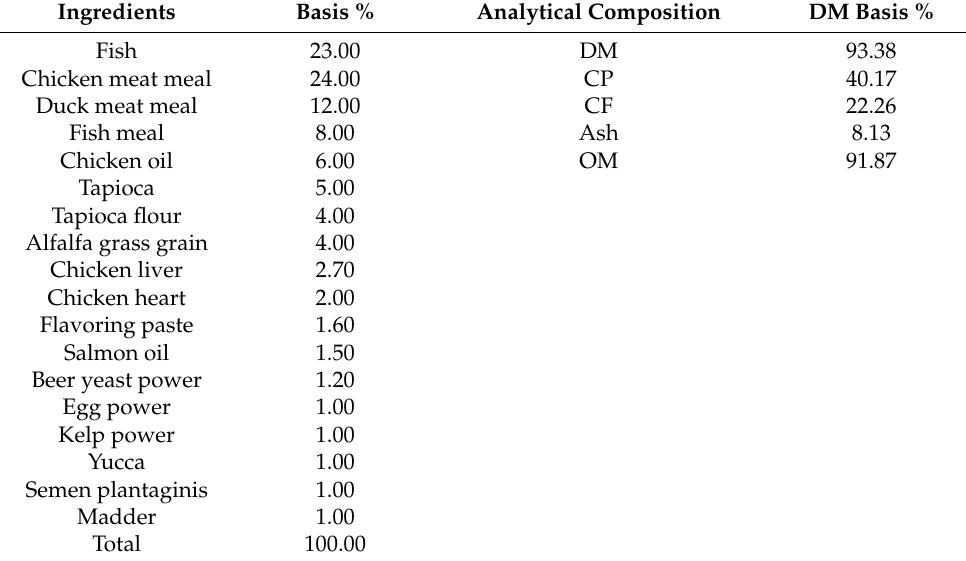
Table 1. Experimental diet and nutrition